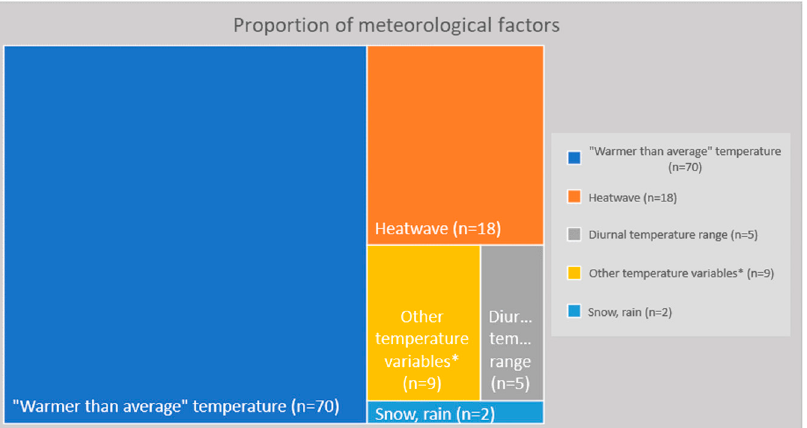
Figure 5. Proportion of meteorological factors used by the authors. ‘Warmer than average’ was usually reported by the authors as high percentiles in relation to a threshold. * Other temperature variables: temperature variability (TV), temperature change between neighboring days (TCN), daily excess hourly heat (DEHH), irregular daily variation.